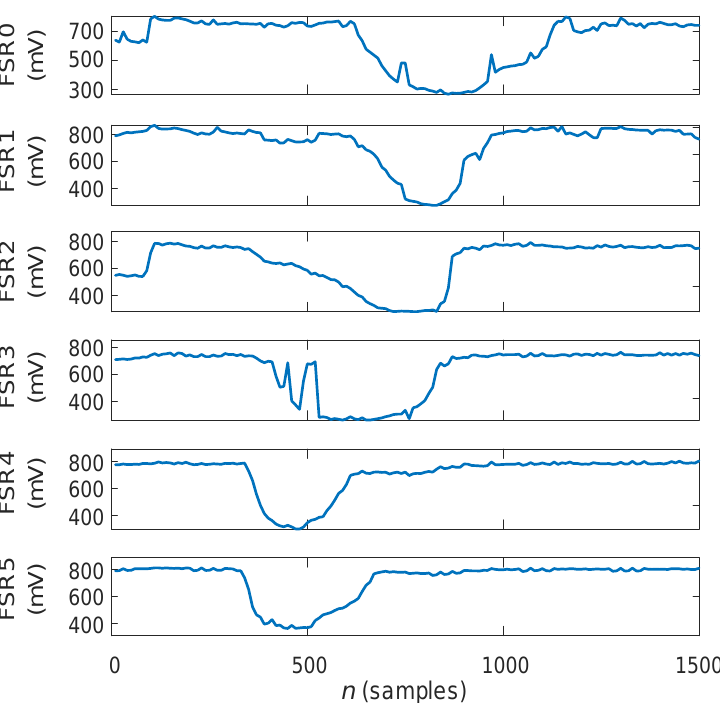
Figure 17. The FSR recordings during a stance phase, following the successive activation of FSR 5 — heel area, FSR 4 to FSR 1 —midfoot, and FSR 0 —hallux.